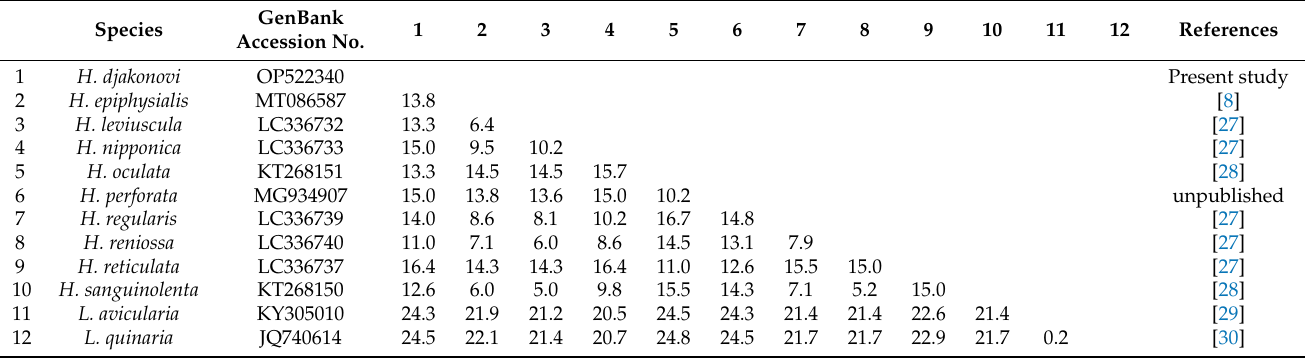
Table 2. Pairwise genetic distances (%) within 12 asteroids, comprising 10 species of Henricia and two species of Luidia , from South Korea and GenBank, based on the Kimura 2-parameter